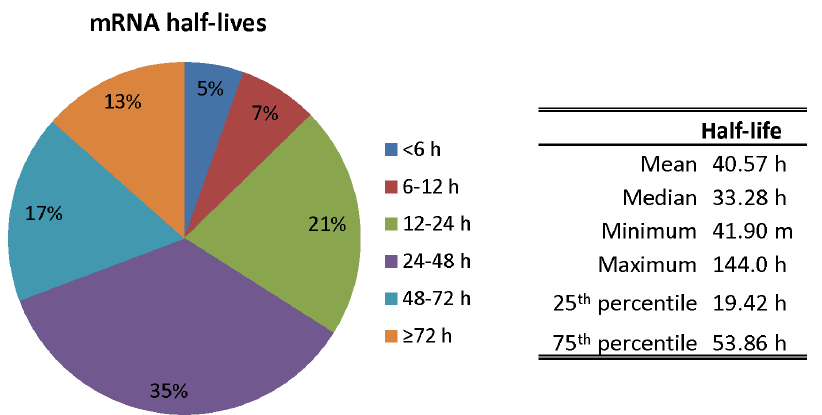
Figure 3. Kareniabrevis mRNA half-lives. Following 2 h incubation with 0.2 mM 4-thiouracil, total RNA was biotinylated and bead purified. Total, pre-existing, and newly synthesized RNA fractions were hybridized to a custom oligonucleotide microarray and mRNA half-lives were calculated for 7086 features using HALO. Following normalization by linear regression, newly synthesized RNA to pre-existing RNA ratios were used to calculate half-lives.